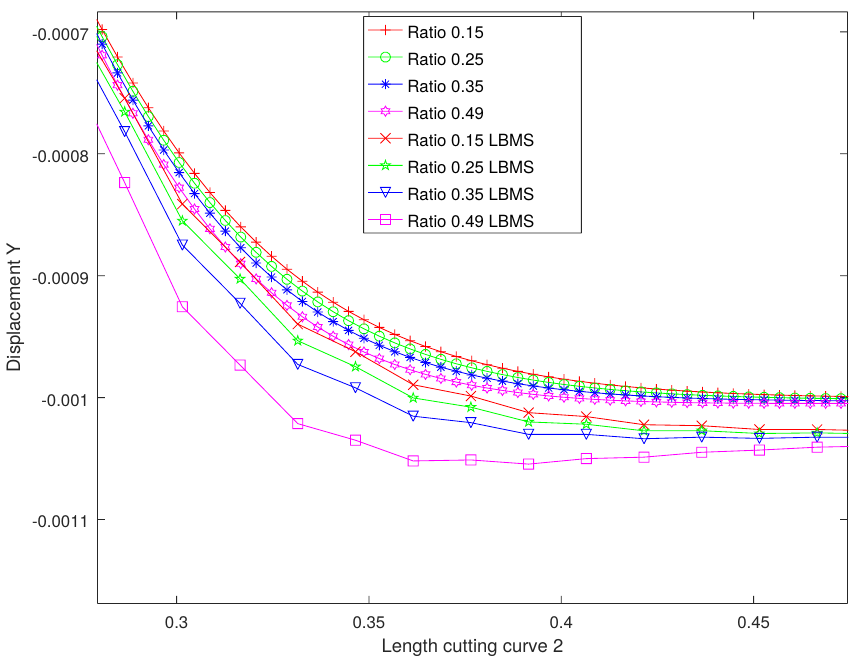
Figure A14. Detailed view of second displacement components along cutting curve C 2 for positive Poisson’s